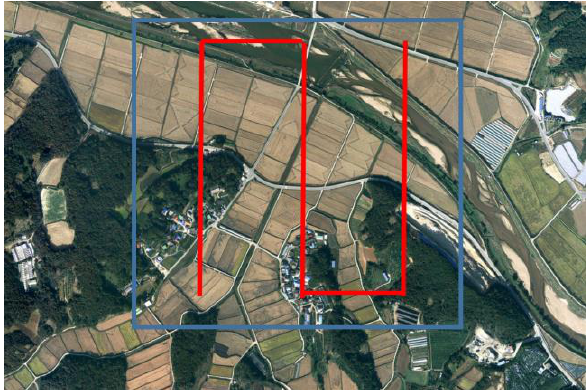
Figure 4. Test field and flight path with flight altitude of 200 m